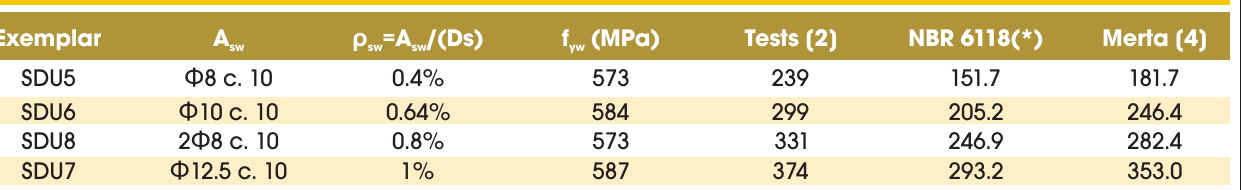
Table 1 – Comparison of shear resistance value in kN – circular section, D=25cm; f =31.7MPa